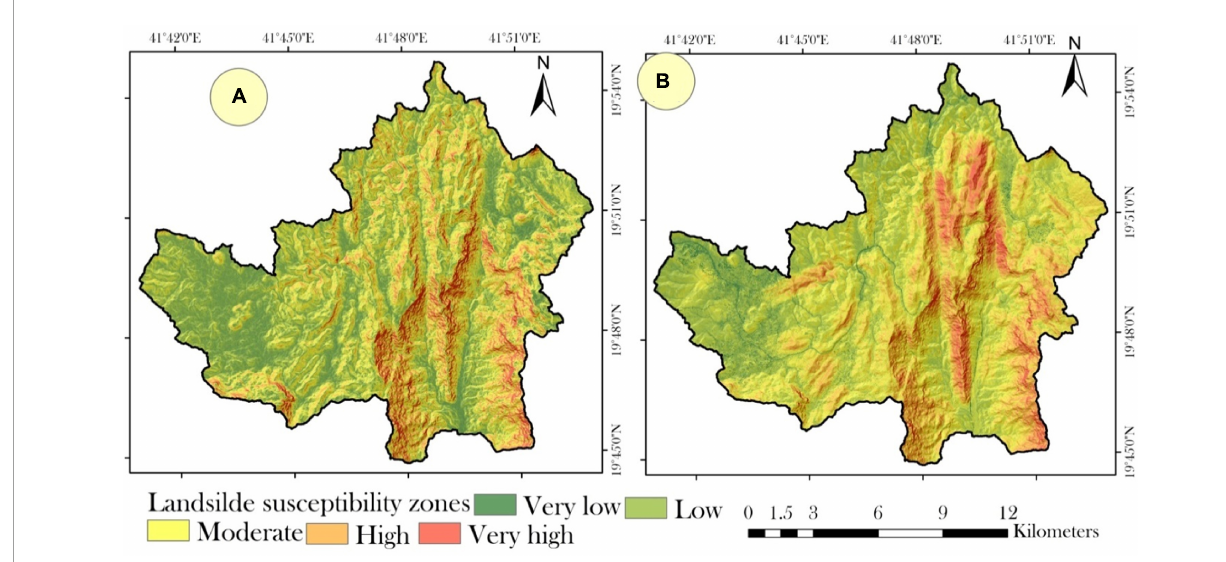
FIGURE11 Landslide susceptibility mapping using (A) DNN and (B) RF models.